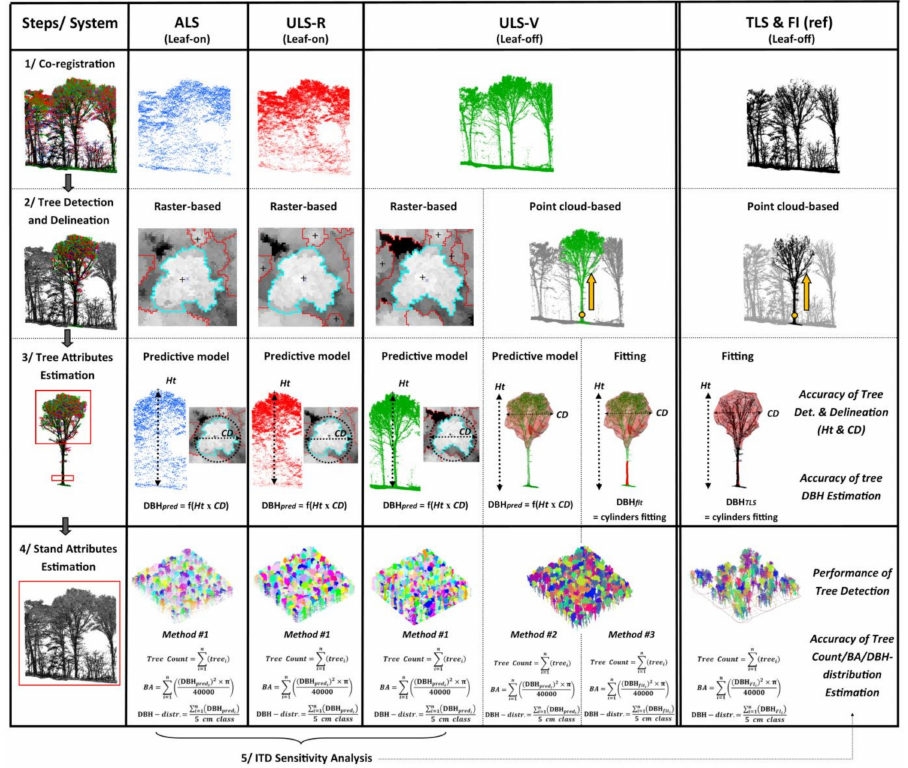
Figure 5. Global workflow illustrating the main steps applied to each aerial dataset, with TLS and FI as reference dataset (evaluation methods are written in italics). Abbreviations: ALS (Airborne Laser Scanning), ULS-R (UAV Laser Scanning—Riegl Vux-1LR), ULS-V (UAV Laser Scanning—Velodyne HDL-32E), TLS (Terrestrial Laser Scanning), FI (Field Inventory), Ht (Height), CD (Crown Diameter), DBH (Diameter at Breast Height), DBH pred (DBH predicted), DBH fit (DBH fitted), BA (Basal Area), and DBH distr. (DBH-distribution). Mathematical equations in steps 3 and 4 are described in Sections 3.5 and 3.6, respectively. Methods #1, #2, and #3 are described in Section 3.5.2.